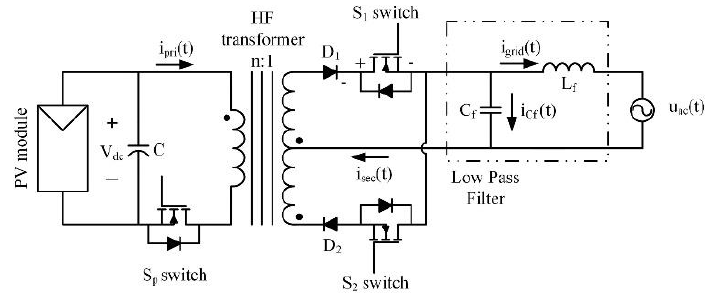
Figure 1. Flyback inverter topology diagram.